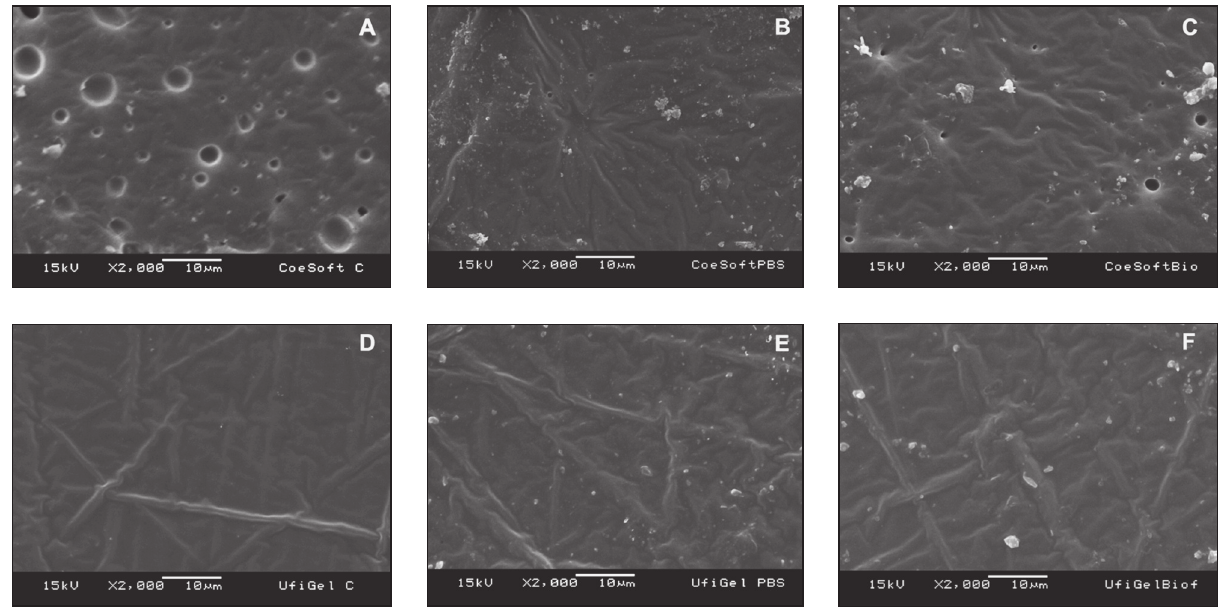
Figure 1 - SEM images of PMMA-based ( A to C ) and silicone-based ( D to F ) denture liners at baseline ( A and D ), after 12 days of storage in PBS ( B and E ), and after accumulation of a biofilm (surface cleaned before imaging; C and F